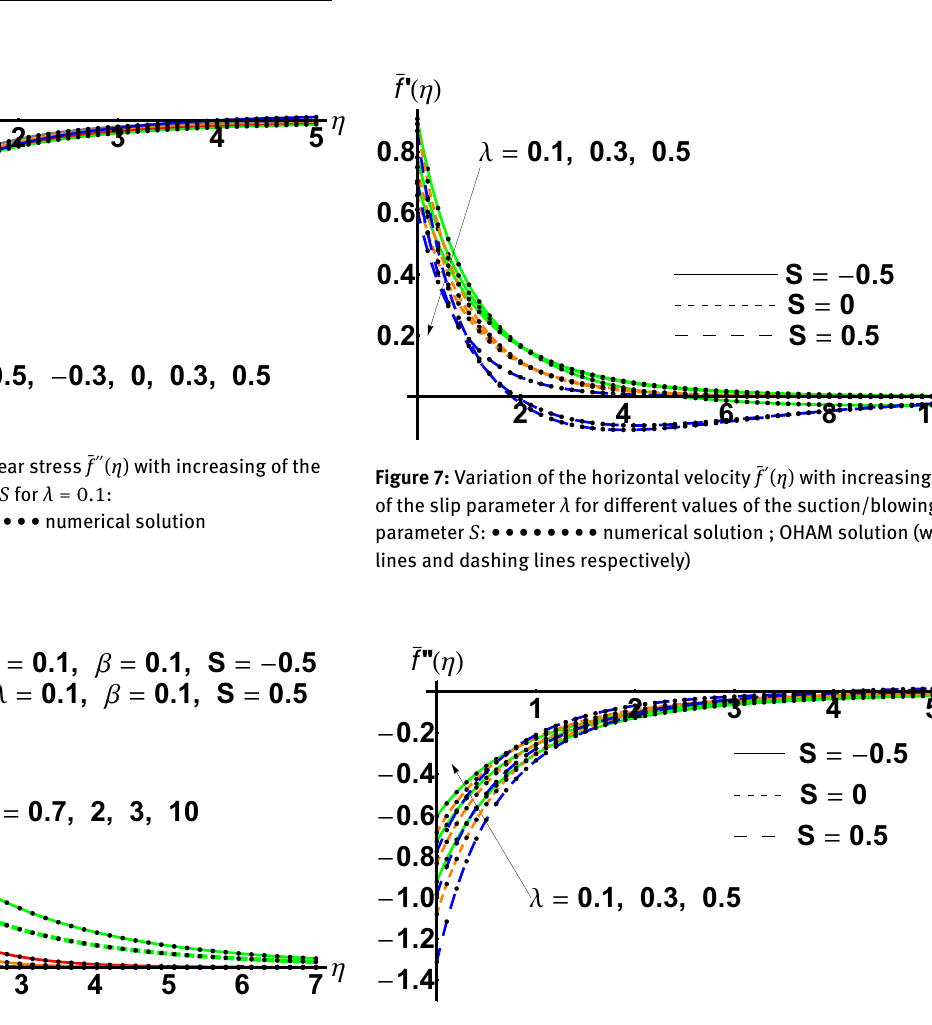
Figure 5: Variation of the concentration ¯ φ ( η ) with increasing of the Schmidt number Sc for λ = 0.1 , β = 0.1 and different values of the suction/blowing parameter S : ••••••• numerical solution ; OHAM solution (with lines and dashing lines respectively)